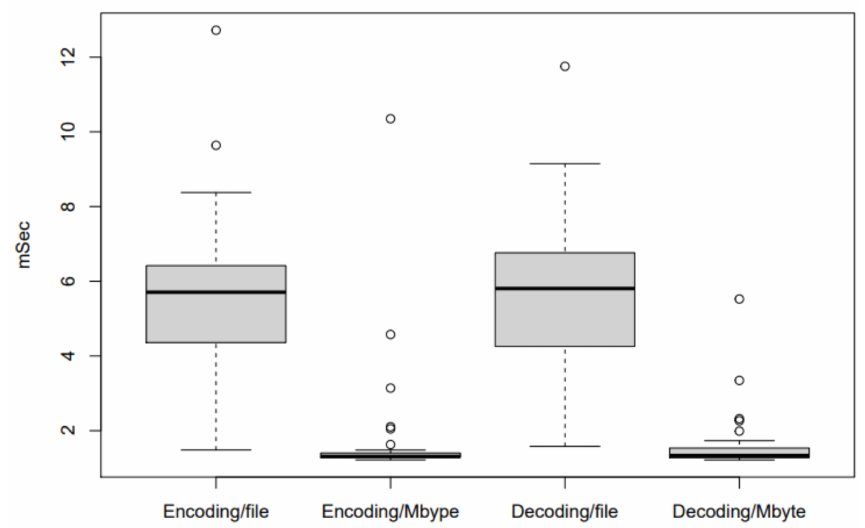
Figure 8. Boxplot with outlier (R Studio 1.3).